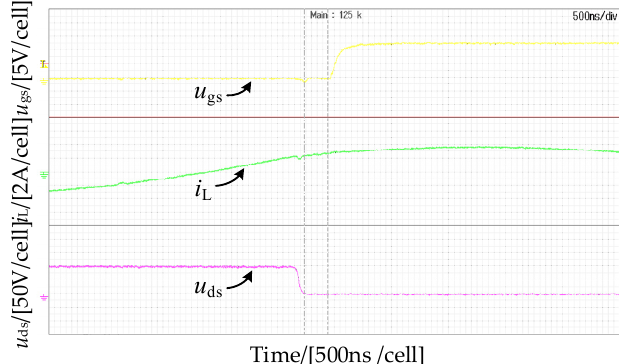
Figure 35. Bridge-arm C soft-switching waveform diagram. The waveforms of reactive power and active power are shown in Figure 36, where channel 1 is the voltage u AB waveform at the midpoint of the two bridge arms on the primary side, channel 2 is the resonant current waveform, channel 3 is the voltage u DC waveform at the midpoint of the two bridge arms on the secondary side and channel 4 is the output current waveform.